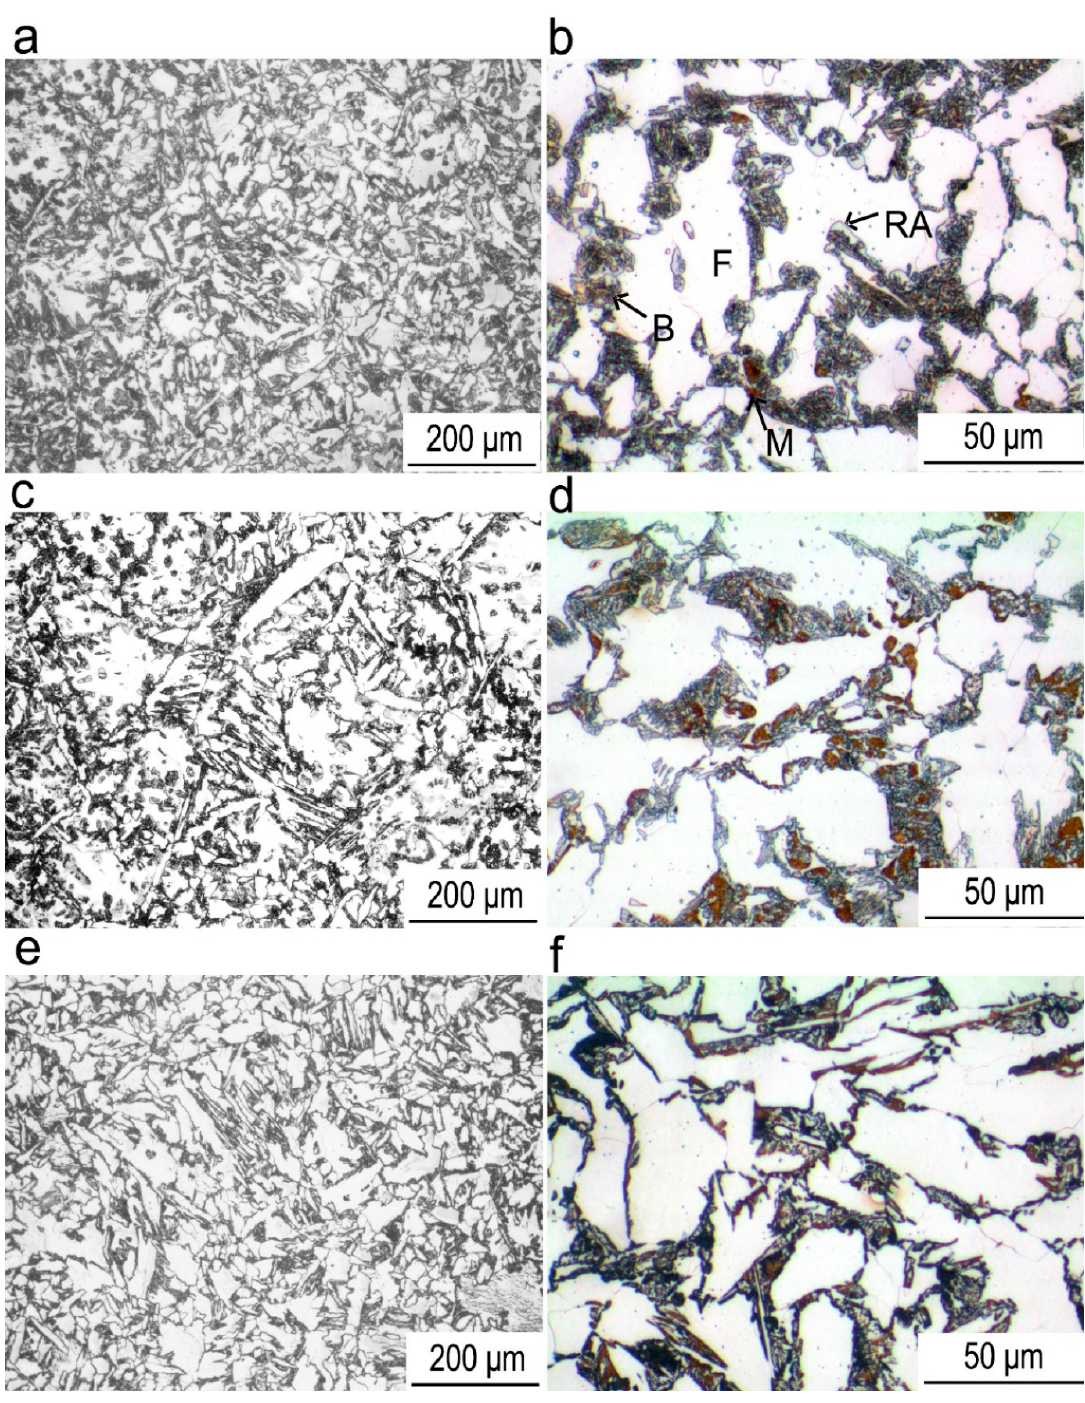
Figure 9. Optical microstructures after holding at ( a , b ) 400 °C, ( c , d ) 450 °C and ( e , f ) 500 °C for 900 s (15 min) following holding at 750 °C for 240 s: ( a , c , e ) nital and ( b , d , f ) colour etched microstructures. Ferrite is shown with grey/white, bainite with dark grey/bluish, retained austenite with grey/white and martensite with brown colours in ( b , d , f ). F is ferrite, B is bainite, M is martensite and RA is retained austenite.